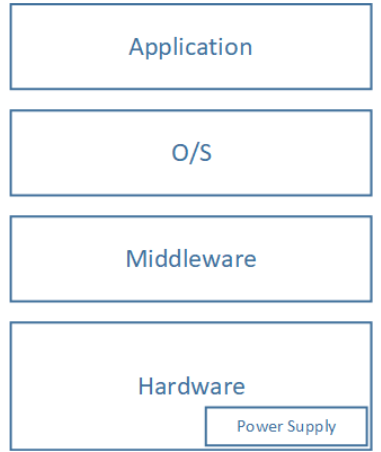
Figure 6. Systemic division of the Perception Layer Entity (PLE)